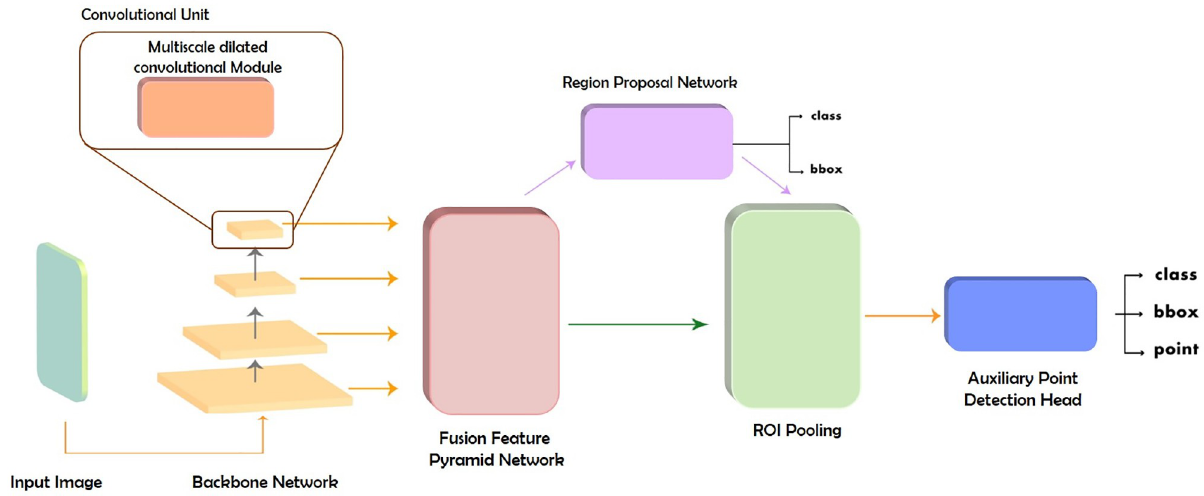
Fig 2. Two-stage object detector incorporated with the three proposed components ( i.e. , the multiscale dilated convolutional module, fusion feature pyramid network, and auxiliary point detection head).